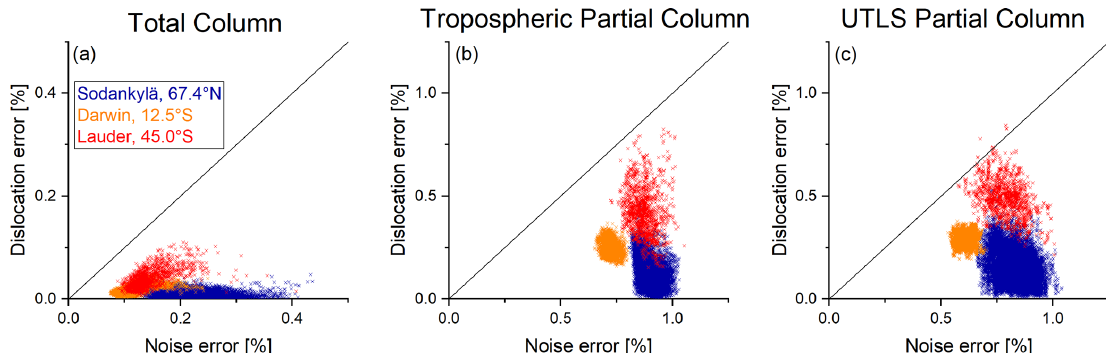
Figure E5. Comparison of the dislocation error (due to the CH 4 dislocation uncertainty) and the noise error (an example of the typical temporal dependencies of the noise error is shown in Fig. 6). The comparison is depicted for a northern high-latitude location (Sodankylä; violet crosses), a tropical location (Darwin; orange crosses), and a southern middle latitudinal location (Lauder; red crosses). (a) Total-column product, (b) tropospheric partial-column product, and (c) UTLS partial-column